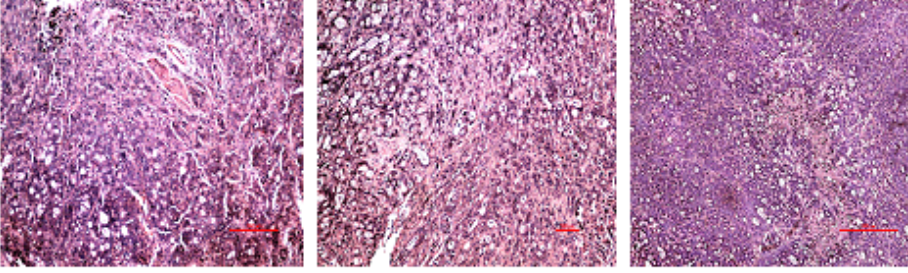
Figure 8. Pathological analysis of knockdown of XRCC2 expression. The effect of XRCC2 shRNA on pathology was examined in nude mice. Mice were treated with either shRNA-XRCC2 or shRNA-SC. Radiation treatment (2 Gy) was given once every other day when tumor volume reached 100 mm 3 in a total of 10 days. The tumor pathology was examined on day 28 after exposure to radiation. (Magnification: ×400; Scale bar: 100 μ